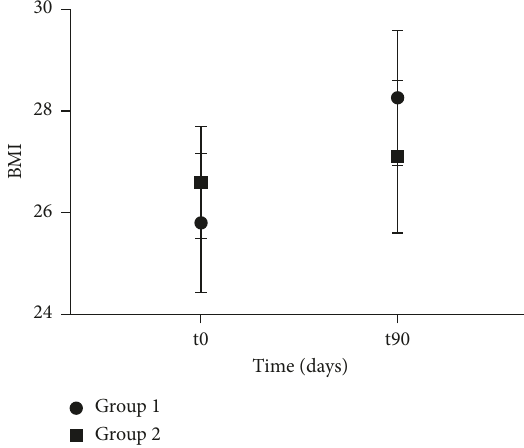
Figure 1: Body mass index variations during the experiment.